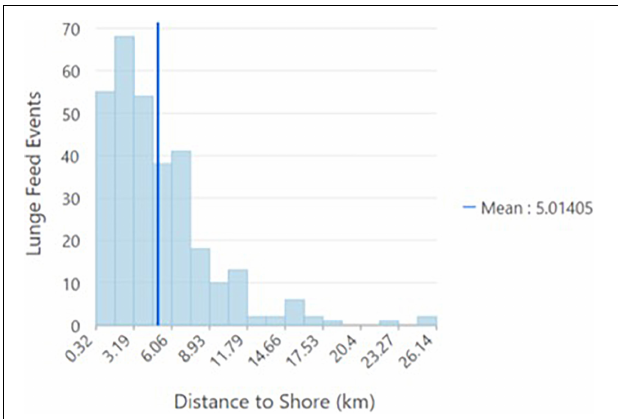
FIGURE 5 | Distribution of distance to shore for each lunge feeding event (2011–2019). Since the data file included elevation and bathymetry, the outcomes were negative since they were below sea